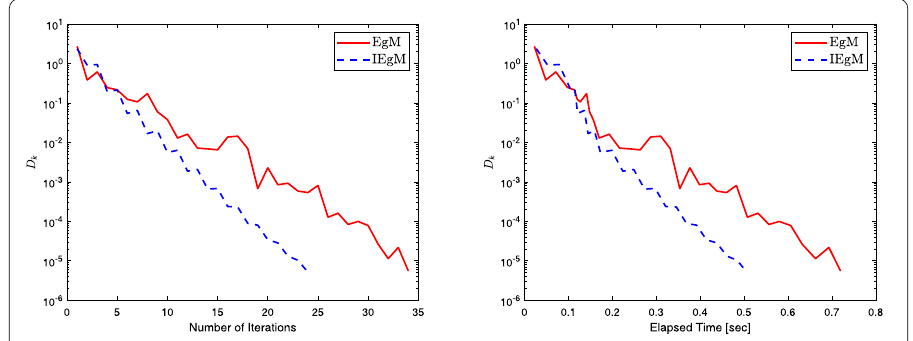
Figure 5 Computational comparability of Algorithm 2 with Algorithm 3.1 in [36] for M = 5